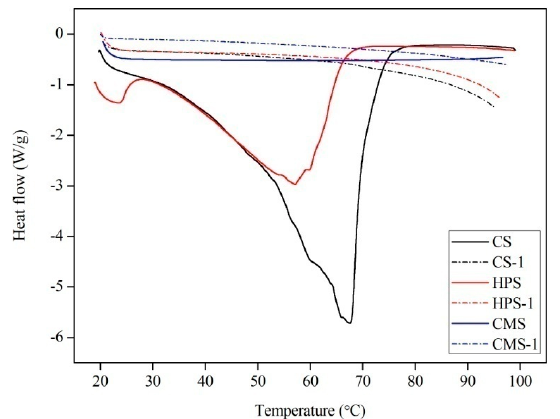
Figure 8. DSC thermographs of the starches with distilled water (CS, HPS and CMS) and the starches with the cement filtrate (CS-1, HPS-1 and CMS-1).